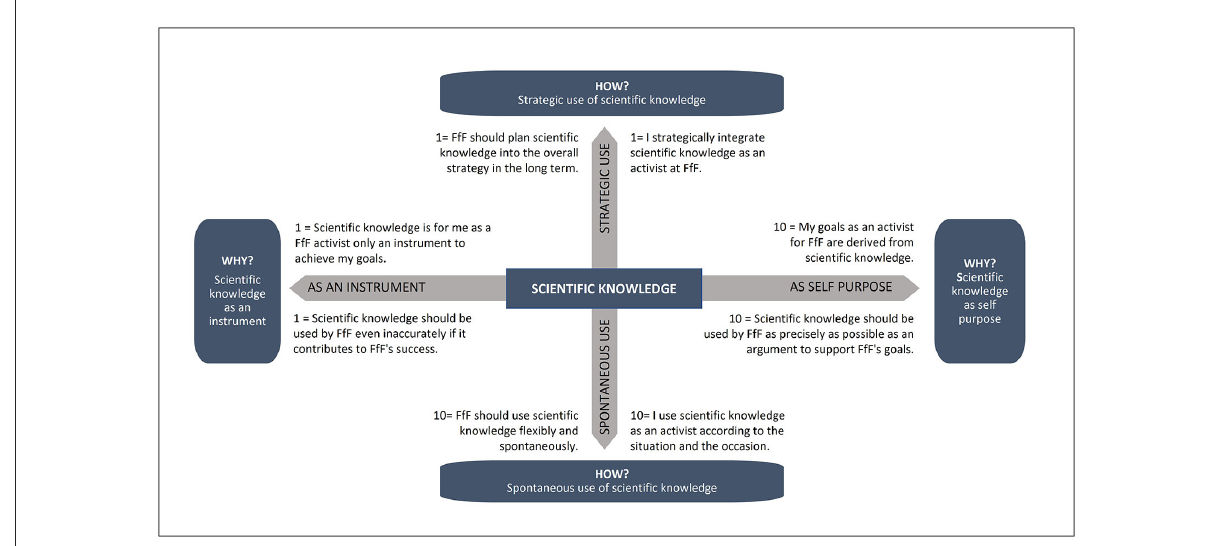
FIGURE1 Four main complementary dimensions and their items along the research question “How and why is scientific knowledge being used by FfF activists to mobilize